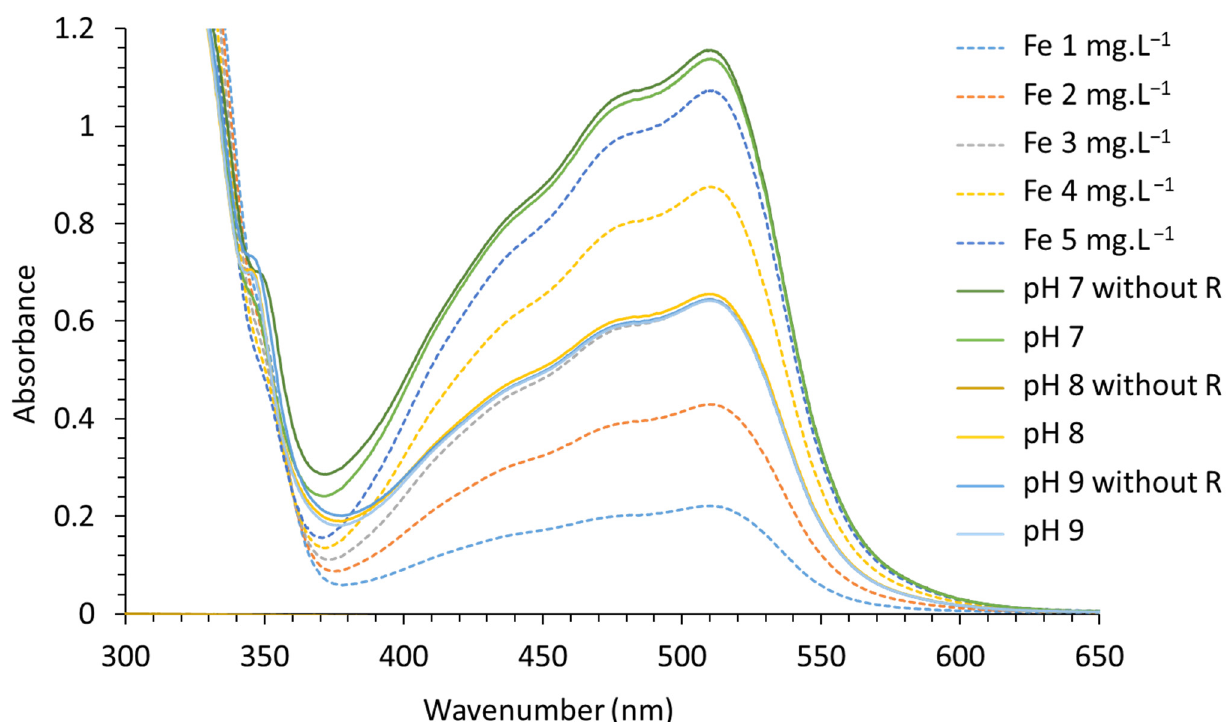
Figure 8. UV–visible absorbance of various concentrations of Fe and synthesized LDHs, with and without the Fe III reducing agent.